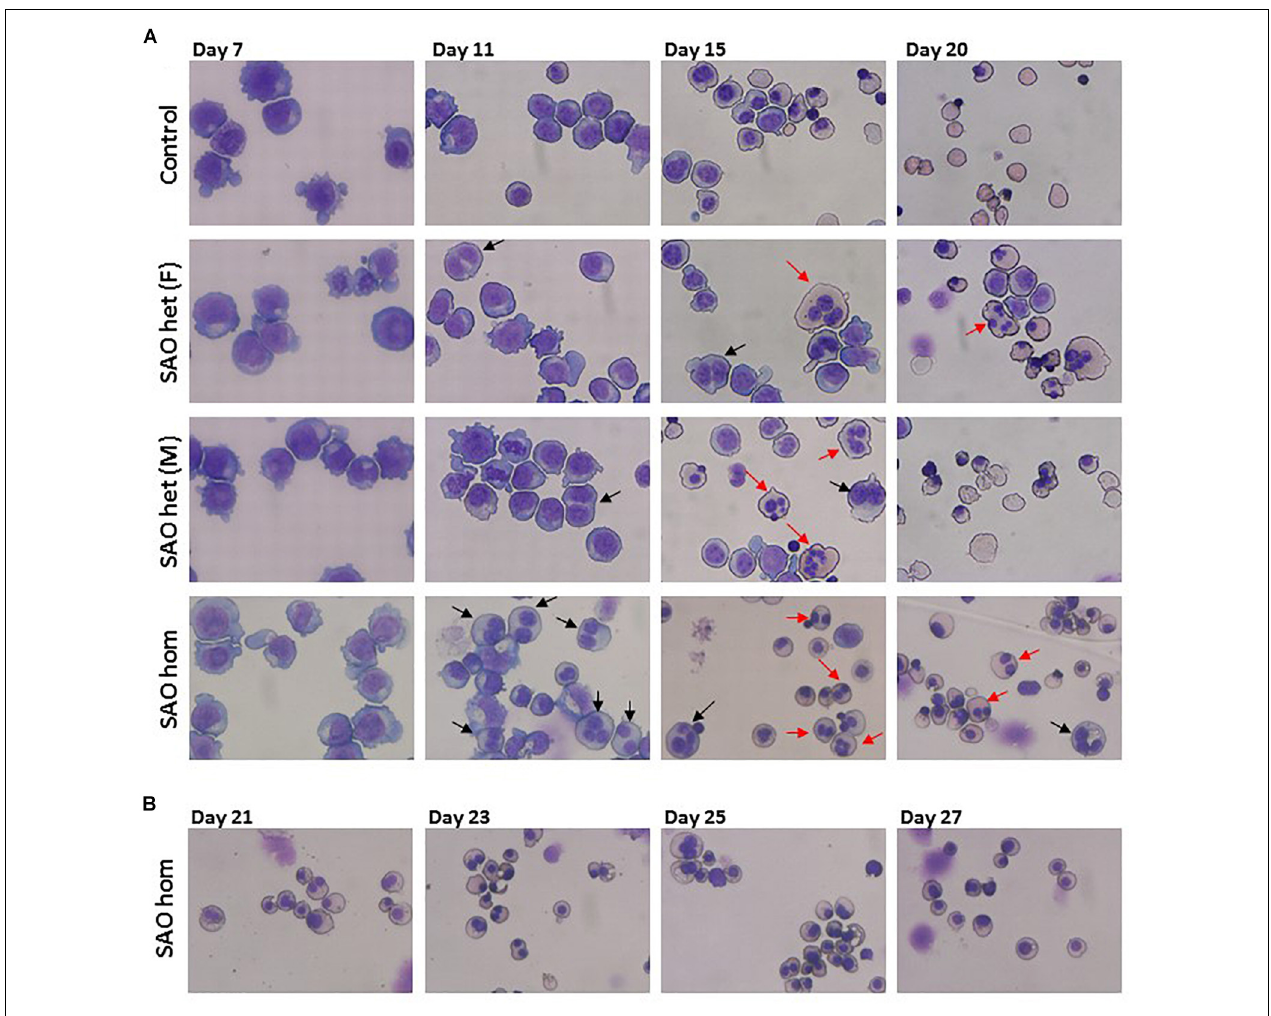
FIGURE 5 | Cytomicrographs of cultured control and SAO CD34 + cells. (A) Comparison of control with heterozygous SAO [(F) = father, (M) = mother] and homozygous SAO cells over 20 days of culture. Bi-nuclear proerythroblasts and basophilic erythroblasts are indicated with black arrows. Multi-nuclear polychromatophilic and orthochromatic erythroblasts are indicated with red arrows. (B) Homozygous SAO cells cultured for a further 7 days did not achieve a significant level of